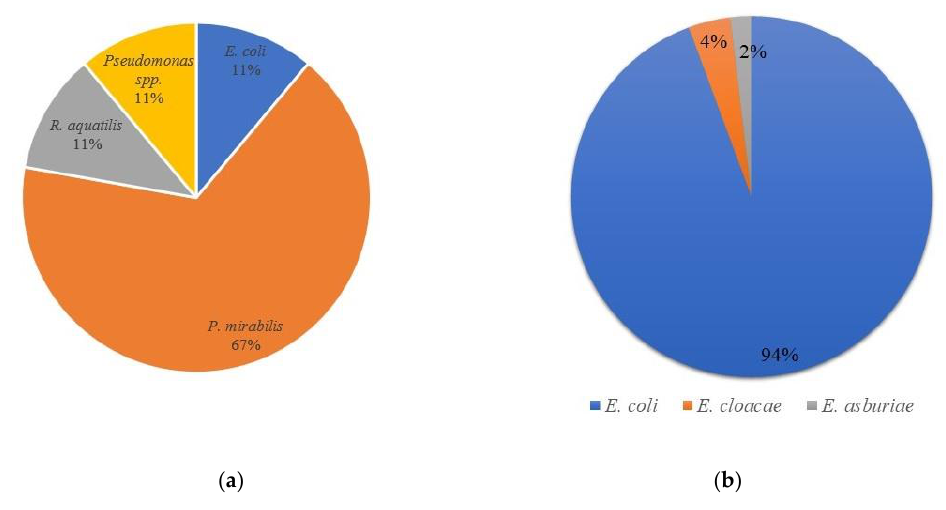
Figure 3. Distribution of Enterobacteriaceae in milk ( a ) and cheese ( b ).